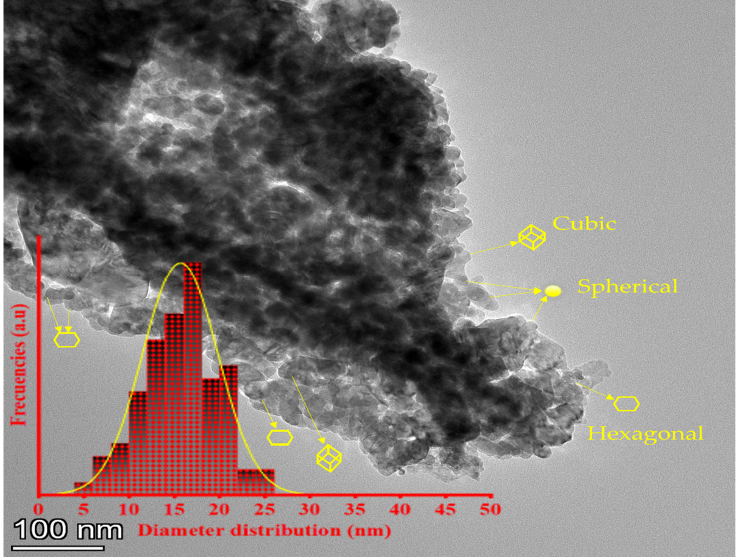
Figure 3. Transmission electron microscopy (TEM) of the ZnO-NPs synthesized utilizing an aqueous extract from Phoenix dactylifera L.